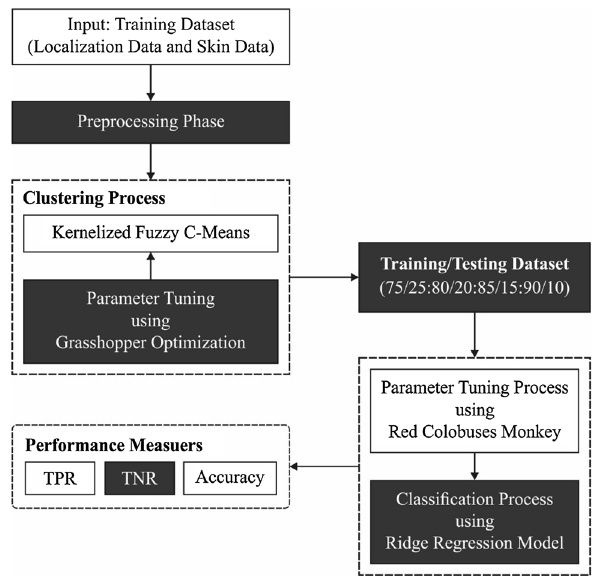
Fig. 2 Block diagram of CICC- BDVMR